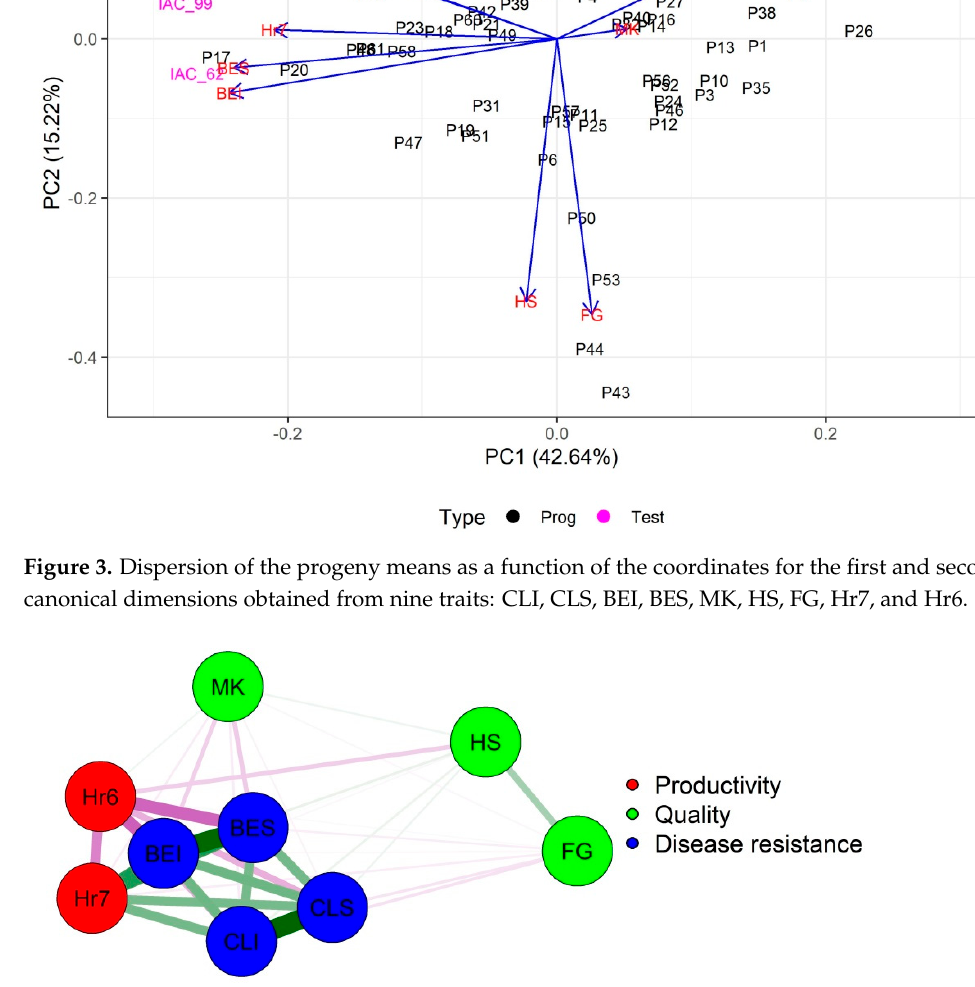
Figure 4. Correlation network of traits related to harvest, grain physical quality and diseases, for CLI, CLS, BEI, BES, MK, HS, FG, Hr7, and Hr6. The circles represent the traits, the color of the line indicates positive (green) and negative (red) correlations, and the thickness of the line denotes the magnitude.